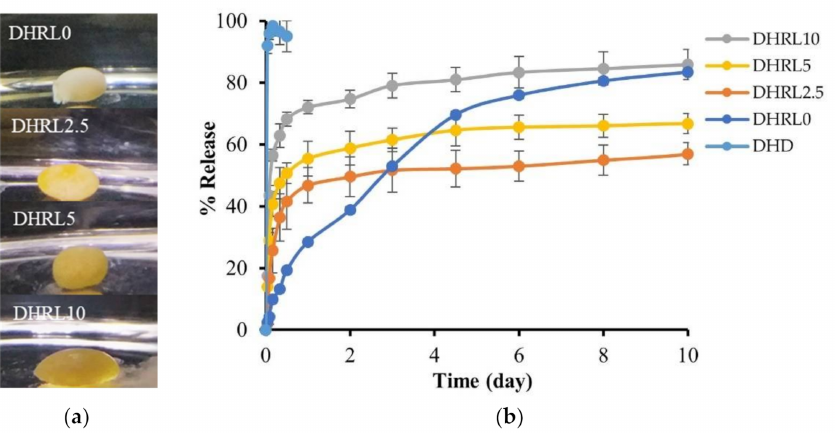
Figure 6. DH-loaded rosin in situ forming gel with various concentrations of LO: ( a ) Gel formation in the release medium after one hour; ( b ) DH release behavior on oil/rosin in situ forming gel over ten days (n =